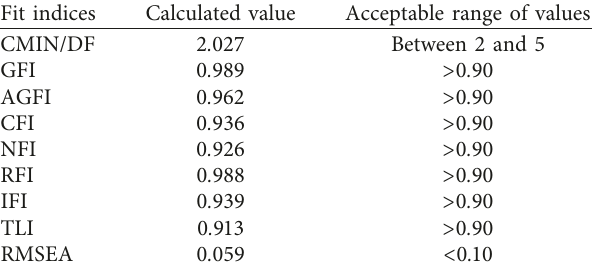
Table 9: Fit indices concerning the modified path